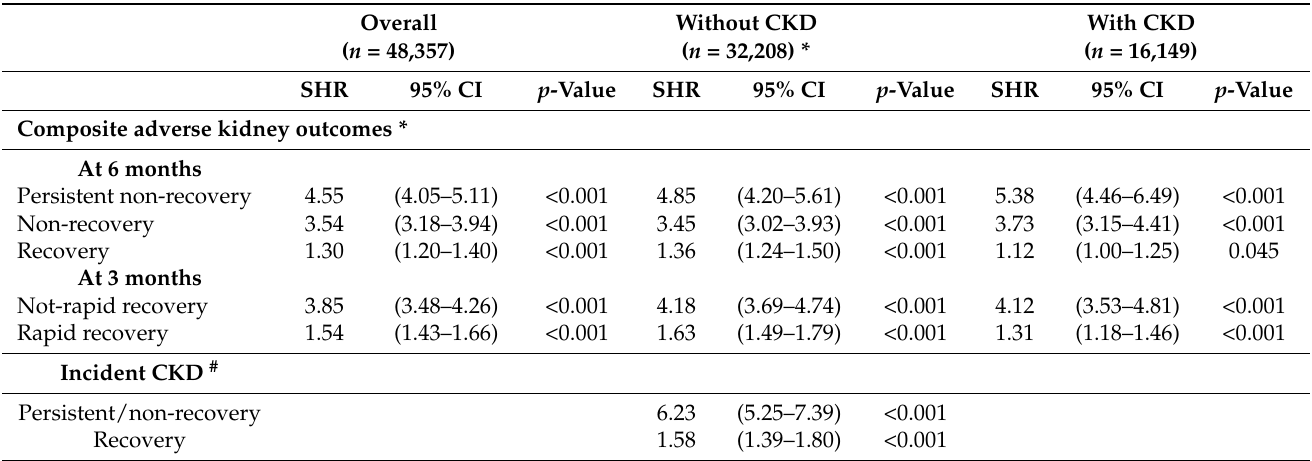
Table 3. Associations between kidney recovery patterns and risk of adverse kidney